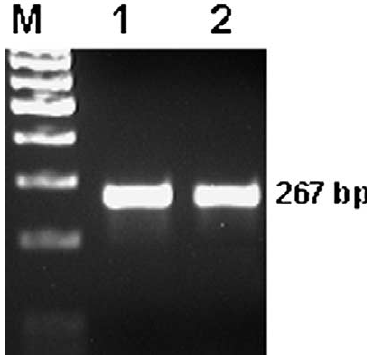
Fig. 3. Agarose gel showing no differences in fragment length be- tween genotypes. M, molecular size marker; lane 1, SW 1088 cell line heterozygous for the inserted intronic thymine; lane 2, A-172 cell line homozygous for the inserted intronic